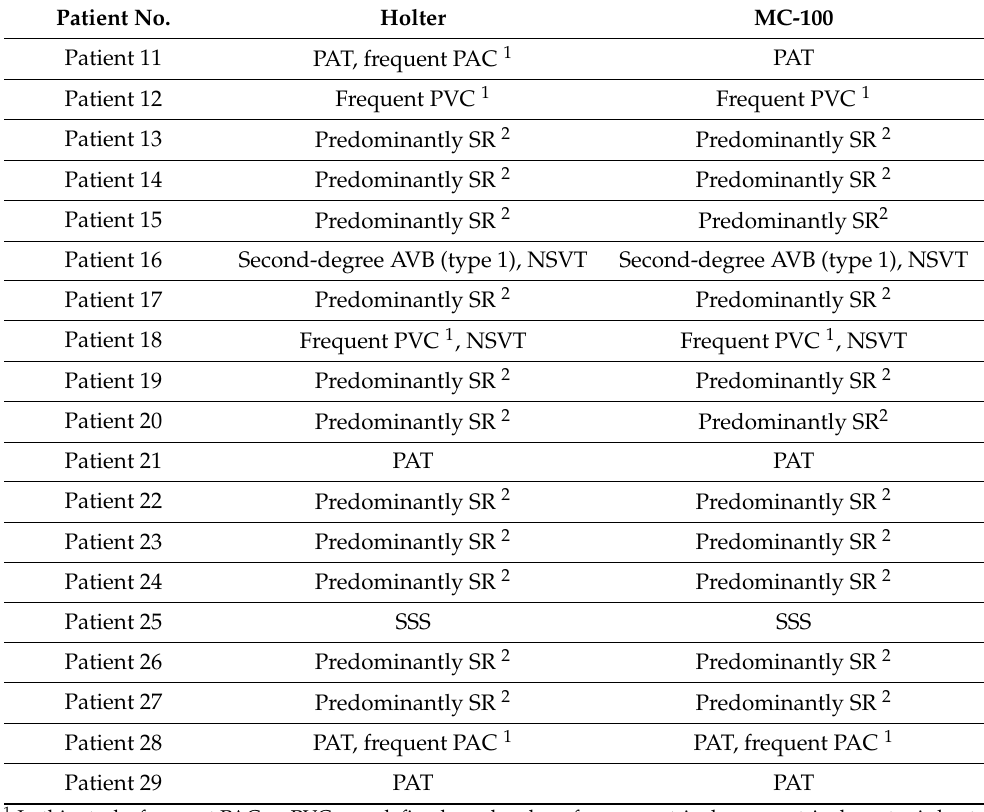
Table 4. Cont. Patient No.